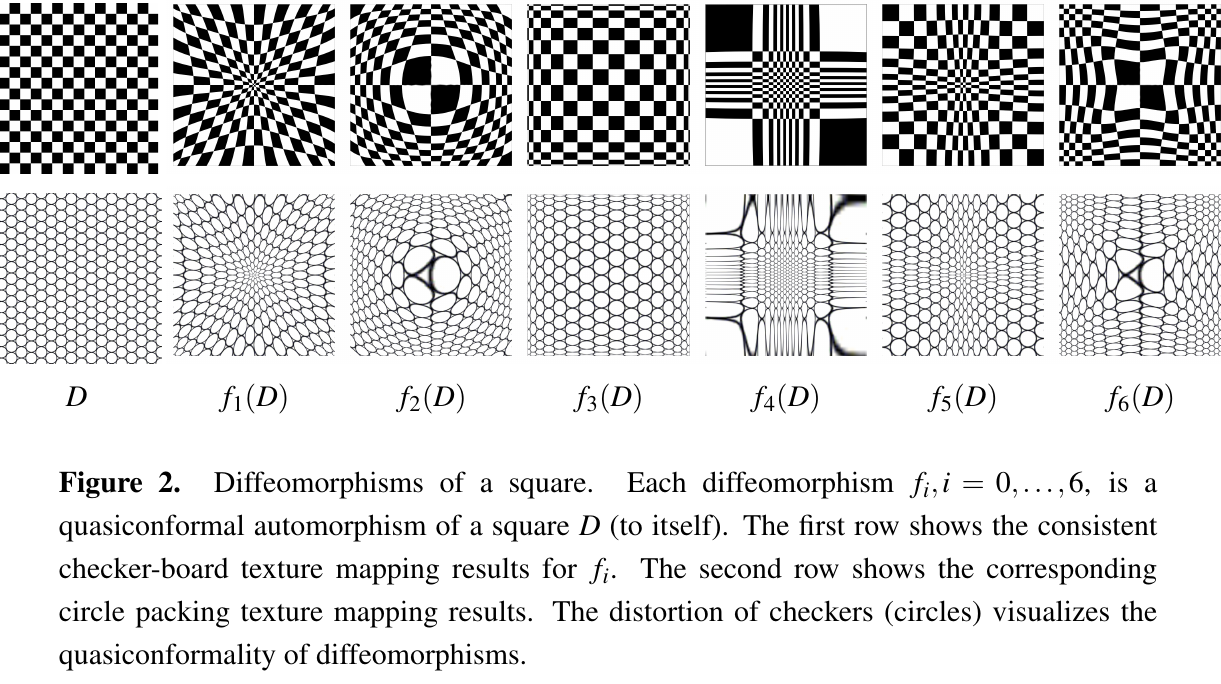
Figure 2. Diffeomorphisms of a square. Each diffeomorphism f quasiconformal automorphism of a square D (to itself). The first row shows the consistent checker-board texture mapping results for f i . The second row shows the corresponding circle packing texture mapping results. The distortion of checkers (circles) visualizes the quasiconformality of